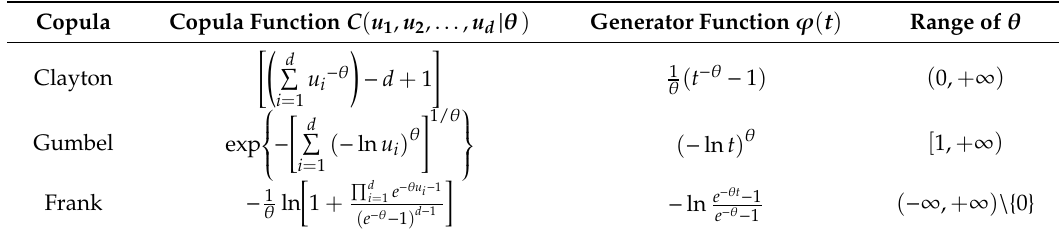
Table 1. Summary of the adopted Archimedean